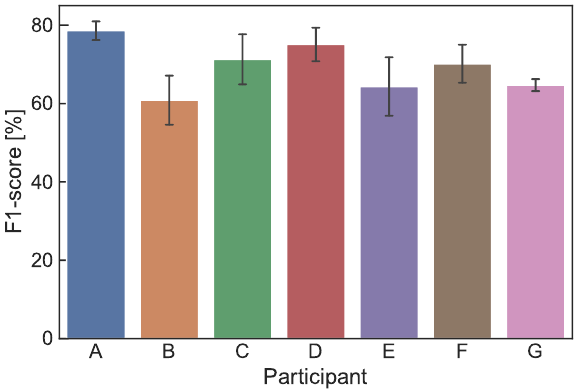
Figure 12. F1 score of each participant